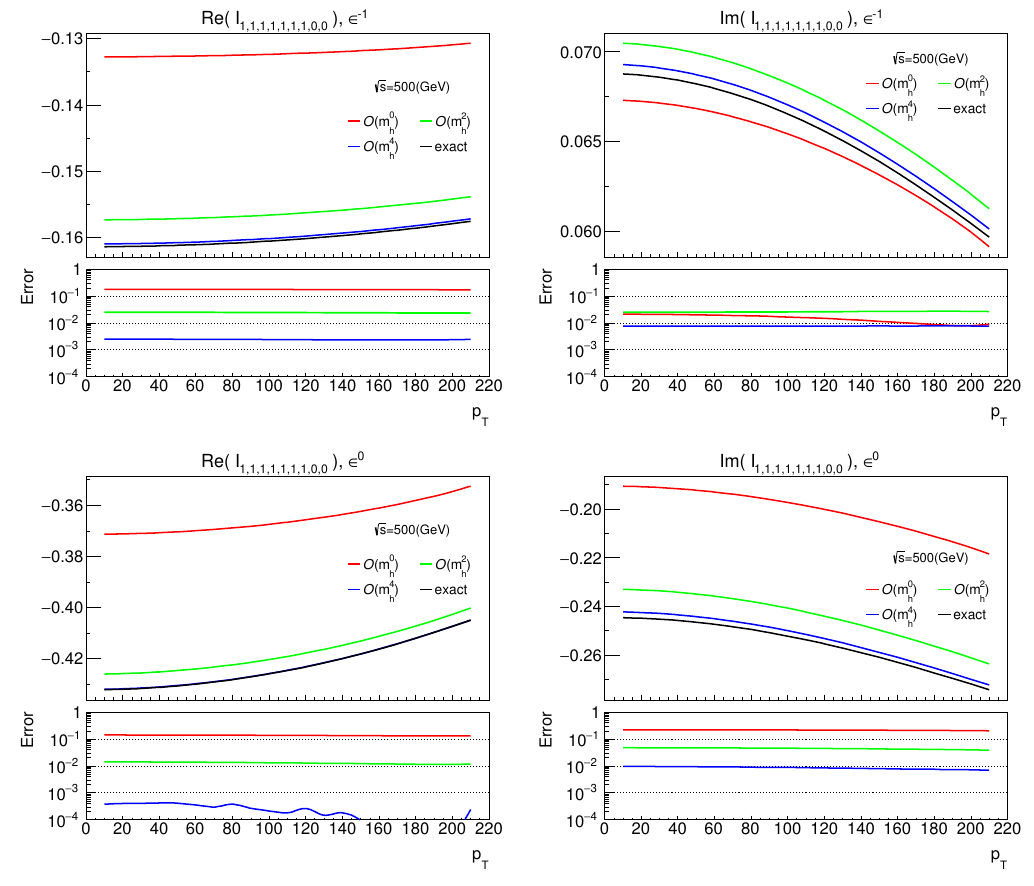
Figure 7 . The real part (left two plots) and the imaginary part (right two plots) of the order (cid:15) (cid:0) 1 and (cid:15) 0 coe(cid:14)cient of the two-loop integral I 1 ; 1 ; 1 ; 1 ; 1 ; 1 ; 1 ; 0 ; 0 in topology E as a function of the Higgs p boson transverse momentum p T with s = 500 GeV. The integral has been multiplied by m 6 make it